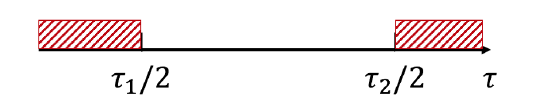
Figure 2 . Independent vacua of the theory invariant under G can be restricted between τ 1 / 2 and τ 2 / 2